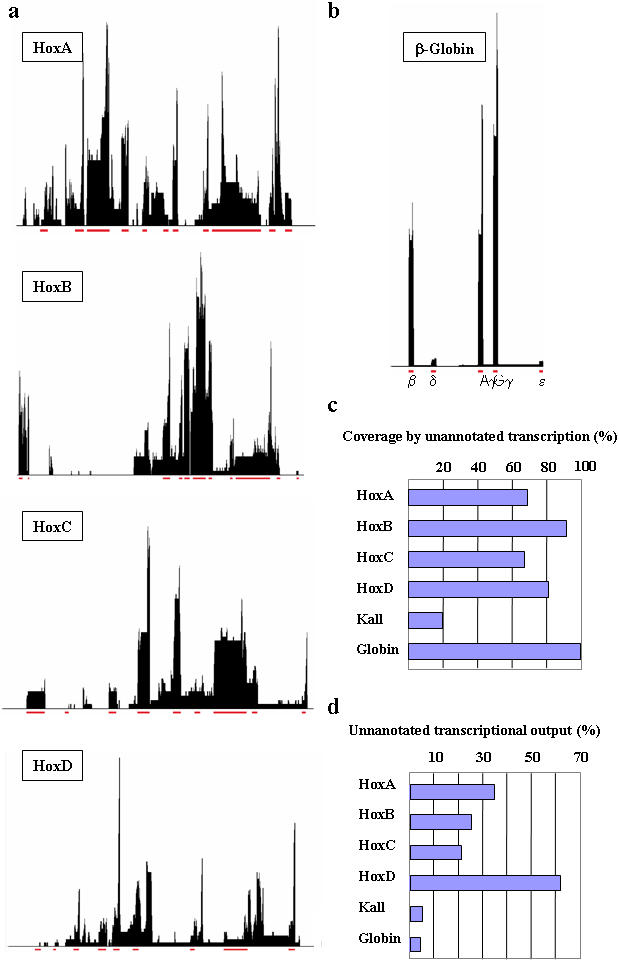
Transcription profiles of the Human Hox clusters.(a) Human Hox Cluster transcriptographs. (b) Transcriptograph of the human β-globin cluster. Note that despite an extensive transcription, the vast majority of sequences correspond to annotated genes. In 1a and 1b, annotations of genes in Refseq are depicted in red. (c) Proportion of the clusters that are primarily transcribed (d) Amount of transcription not currently annotated.